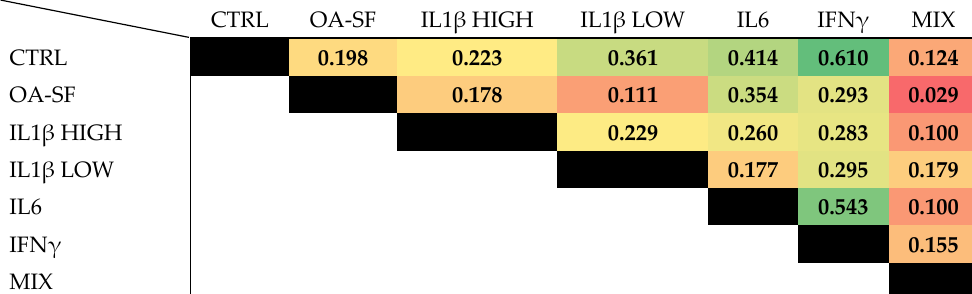
Table 3. Correlation analysis of the stability rankings for single gene expression of control and treated chondrocytes.